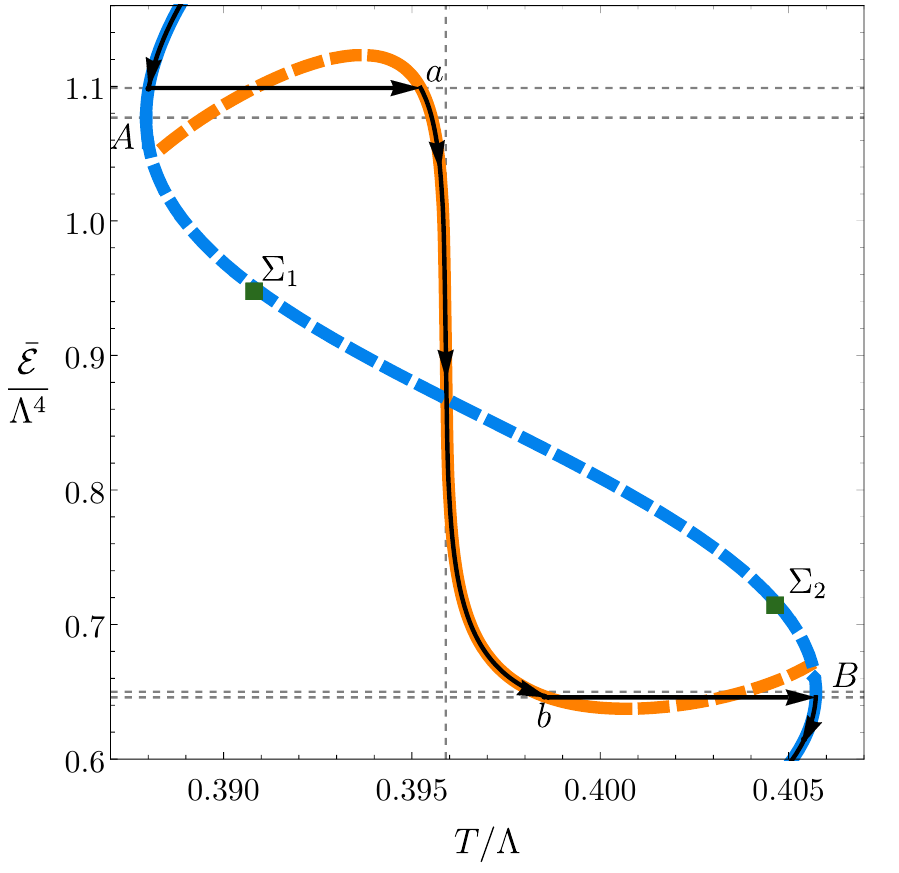
Figure 29 . Phase diagram in the microcanonical ensemble for a length ˆ L ’ 11 . 501849 such that ˆ L K < ˆ L Σ < ˆ L Σ < ˆ L . The blue and the orange curves correspond to homogeneous and 1 2 inhomogeneous states, respectively. The orange curve is the same as the curve of orange circles in figure 11. Solid segments indicate locally dynamically stable states; dashed segments indicate unstable ones. The black curves with arrows indicate the sequence of globally preferred, maximum- entropy states as the average energy density decreases. The points a and b corrrespond to those in figure 18. The first and fourth (from top to bottom) dashed horizontal lines indicate the energy densities at these points, whereas the second and third lines indicate the energy densities at the turning points A and B . The phase transitions between the homogeneous and the inhomogeneous branches, indicated by the horizontal arrows, are